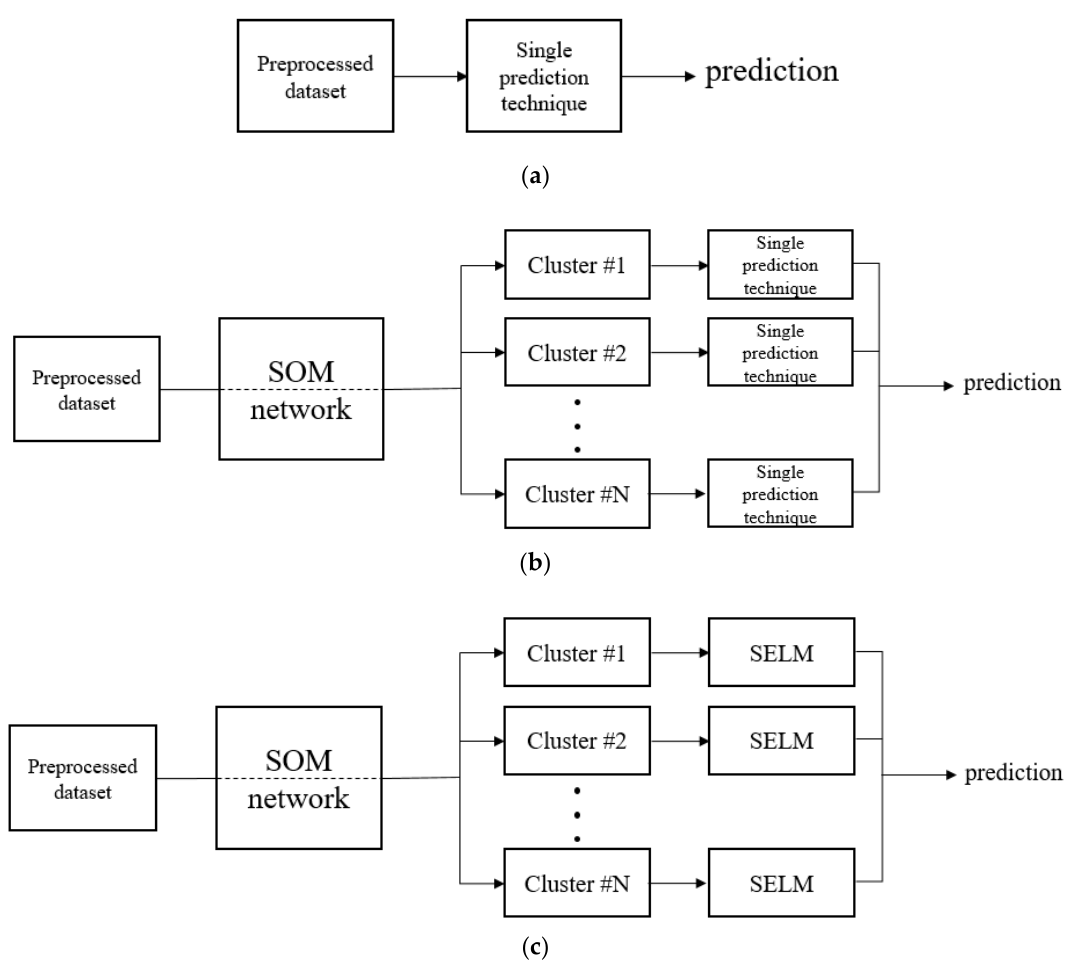
Figure 5. ( a ) Model 1, ( b ) Model 2, and ( c ) Model 3. The “preprocess dataset” in the figure is the result of the original dataset having gone through the process of the front part of Figure 4.